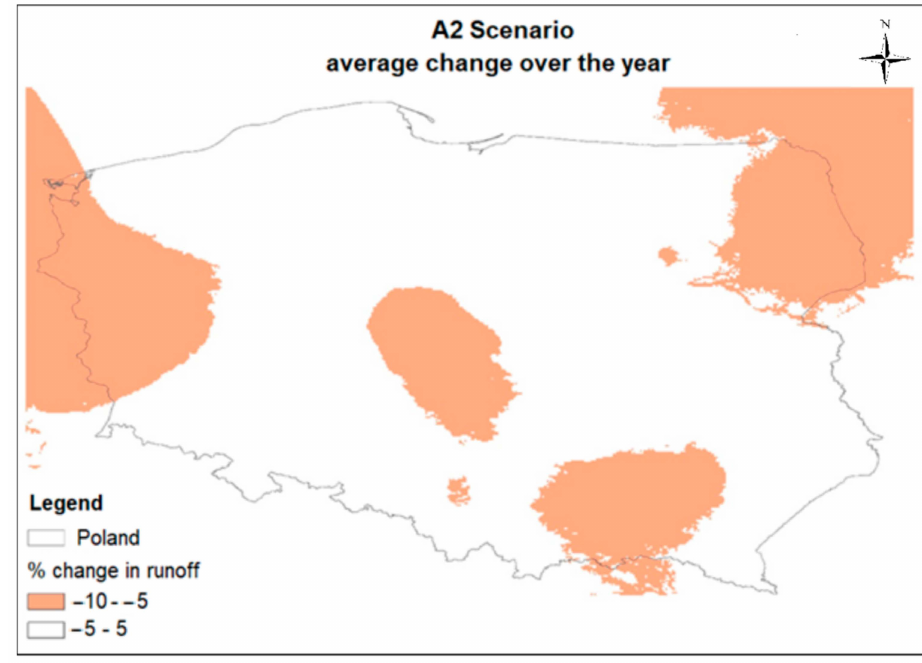
Figure 21. Results of climate change impact modeling—scenario